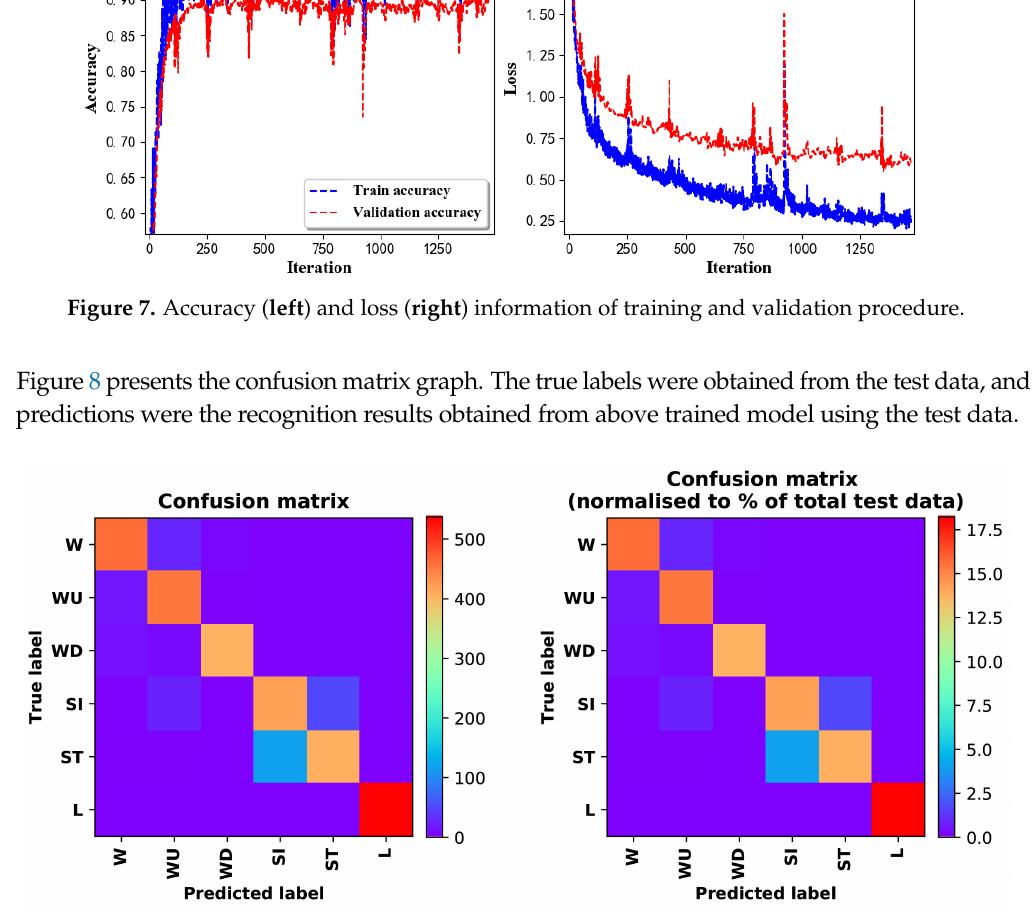
Figure 8. Left graph is the confusion matrix of classification test using the model trained by LSTM network; right is the normalised confusion